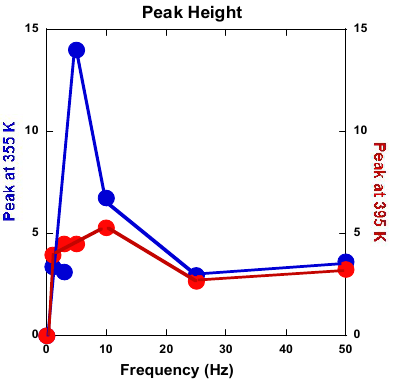
Figure 22. Relative height of the two peaks found on cooling down branch Mg#2 4 B C -175 °C. Lines are guides for the eyes (origin dots have no physical meaning).